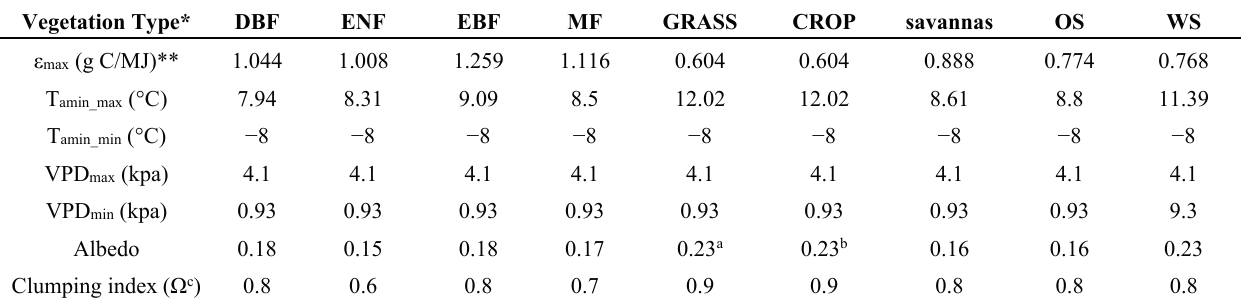
Table 2. Model parameters used for different vegetation